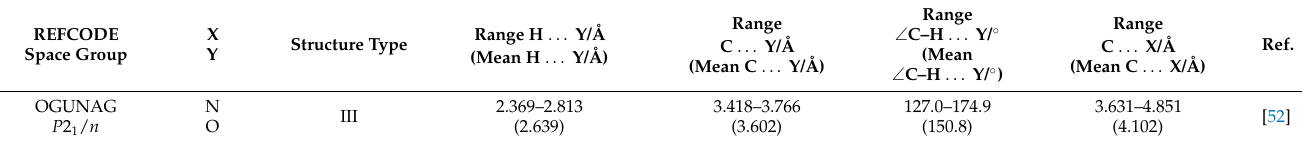
Figure 7. Structure Type III: A side view of part of one [Ni(bpy) 3 ] n 2 n + sheet hosting [NO 3 ] – anions in [Ni(bpy) 3 ] 2 [NO 3 ] 3 [1-CO 2 H-2-SO 3 C 6 H 4 ] . 9H 2 O (refcode OGUNAG [52]). H 2 O molecules, which also contact CH units in the sheet, are omitted for clarity. Table 2. Structure Type III complex with [NO 3 ] – anions.